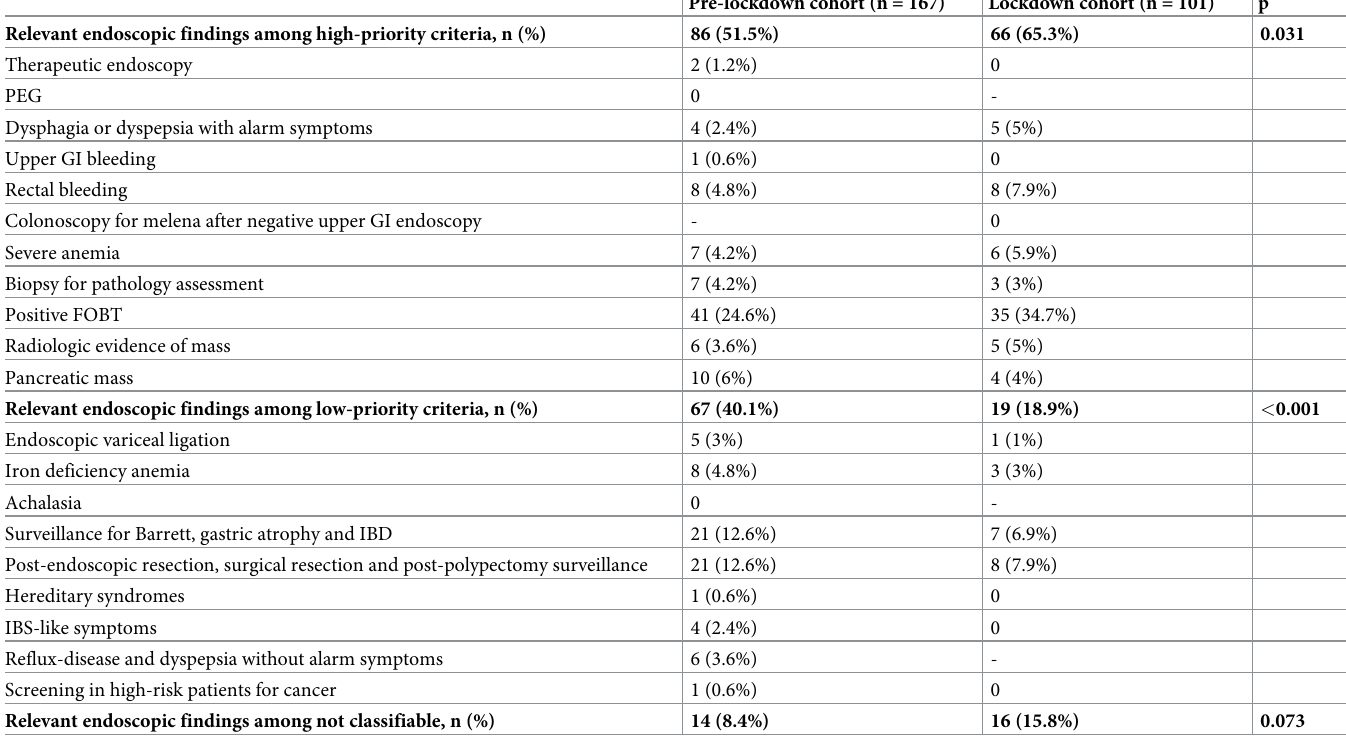
Table 2. Relevant endoscopic findings according to the ESGE high and low-priority criteria observed in the explorations of the pre-lockdown and lockdown cohorts.